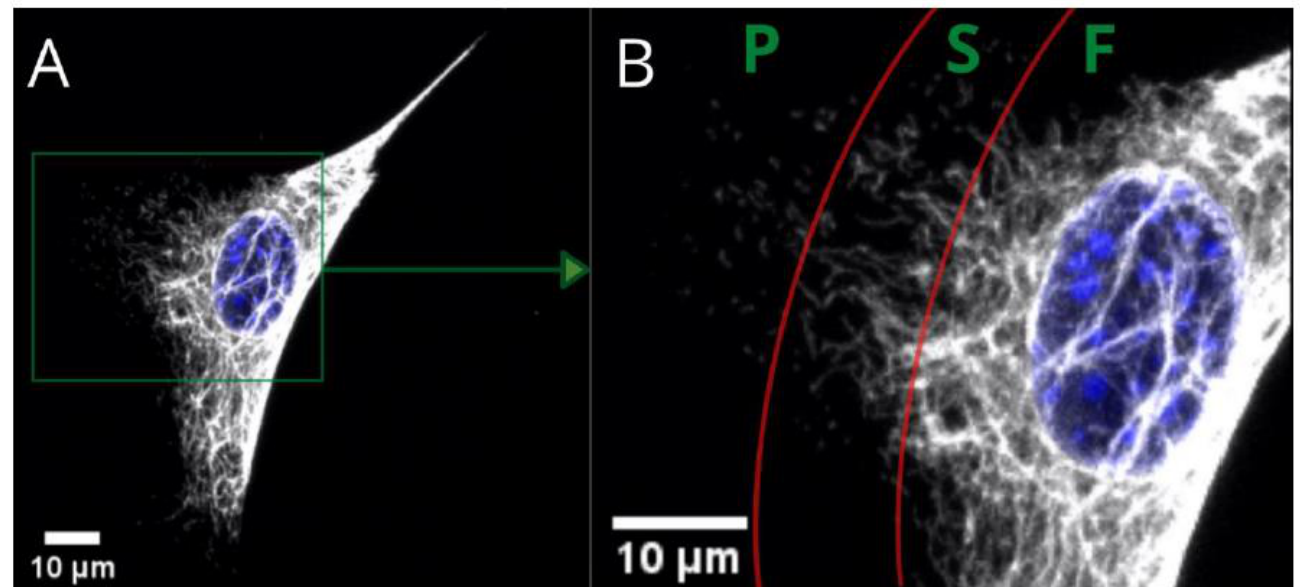
Figure 1. Confocal microscopy image of fibers (F), squiggles (S), and particles (P) of vimentin in a single MEF 3T3 cell. Long vimentin fibers are clearly visible above the nucleus in picture ( A ). Picture ( B ) is a magnified area that shows a gradual transition from fibers to short filaments (squiggles), and from squiggles to particles.